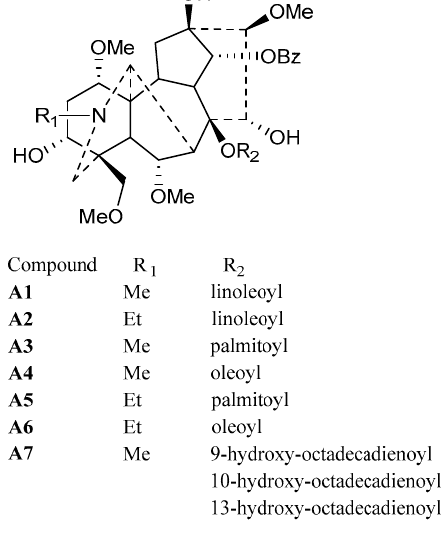
Figure 3. Structures of isolated lipo-alkaloids ( A1 – A7 ).